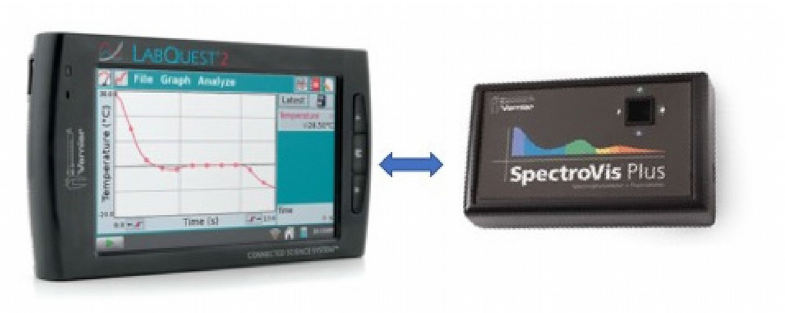
Figure 1. School measurement system